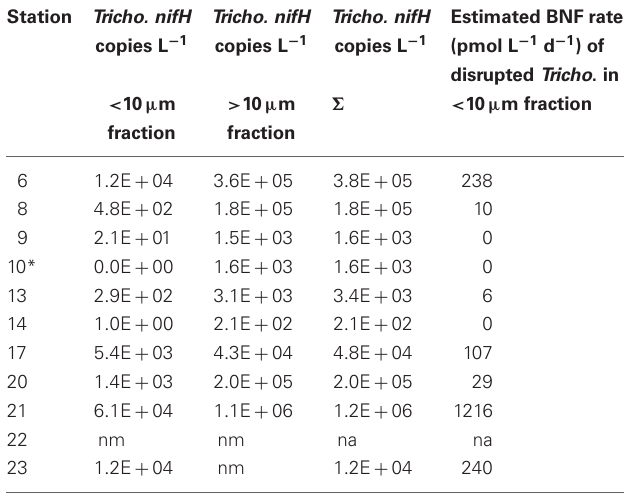
Table 3 | Size-fractionated Trichodesmium nifH qPCR results from natural populations along this cruise track from 5m DNA samples reported in (Goebel et al., 2010), and estimated BNF fixation rates associated with disrupted Trichodesmium colonies measured as part of the small size